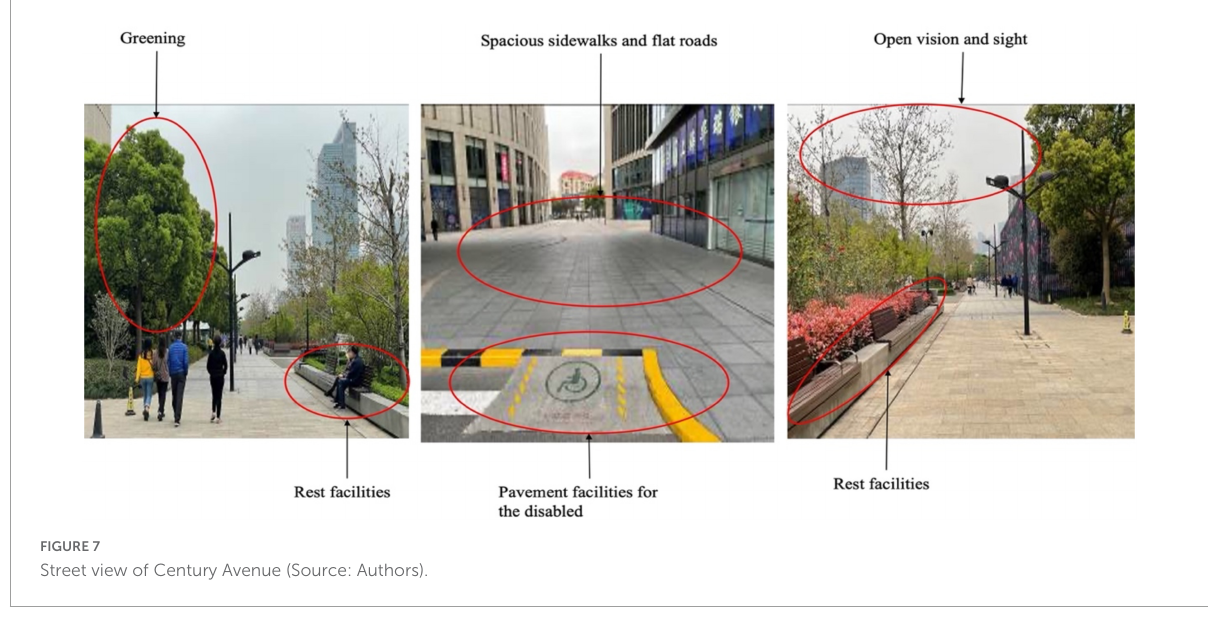
TABLE 6 Findings and planning